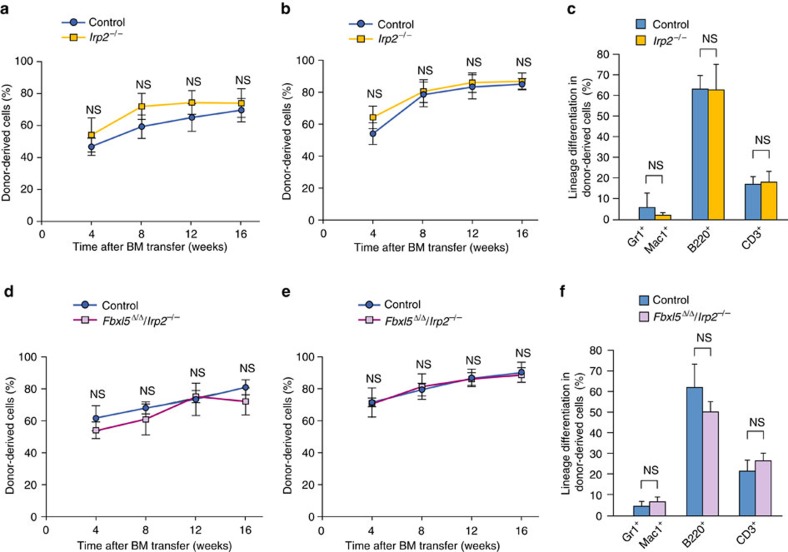
Suppression of IRP2 mediates the effect of FBXL5 on the repopulation capacity of HSCs.(a) Hematopoietic repopulation capacity of Irp2−/− or control (Irp2+/+) BM cells (4 × 105) transplanted together with an equal number of competitor cells. The percentage of donor-derived cells in PB of recipient mice was determined at the indicated times after BM transfer (Irp2−/−, n=5; control, n=4). (b) BM cells (1 × 106) from the recipient mice in a at 16 weeks after BM transfer were serially transplanted into additional recipient mice (n=5), and the percentage of donor-derived cells in PB of the new recipients was determined at the indicated times thereafter. (c) Frequency of differentiated cells (Gr1+Mac1+ myeloid cells, B220+ B cells and CD3+ T cells) in donor-derived blood cells of the recipients in a at 16 weeks after BM transfer. (d) Hematopoietic repopulation capacity of Fbxl5Δ/Δ/Irp2−/− or control (Fbxl5+/+/Irp2+/+) BM cells (4 × 105) transplanted together with an equal number of competitor cells. The percentage of donor-derived cells in PB of recipient mice was determined at the indicated times after BM transfer (n=4). (e) BM cells (1 × 106) from the recipient mice in d at 16 weeks after BM transfer were serially transplanted into additional recipient mice (n=6), and the percentage of donor-derived cells in PB of the new recipients was determined at the indicated times thereafter. (f) Frequency of differentiated cells (Gr1+Mac1+ myeloid cells, B220+ B cells and CD3+ T cells) in donor-derived blood cells of the recipients in d at 16 weeks after BM transfer. Data are means±s.d. NS for comparison of corresponding values for the pairs of genotypes (Student’s t-test).